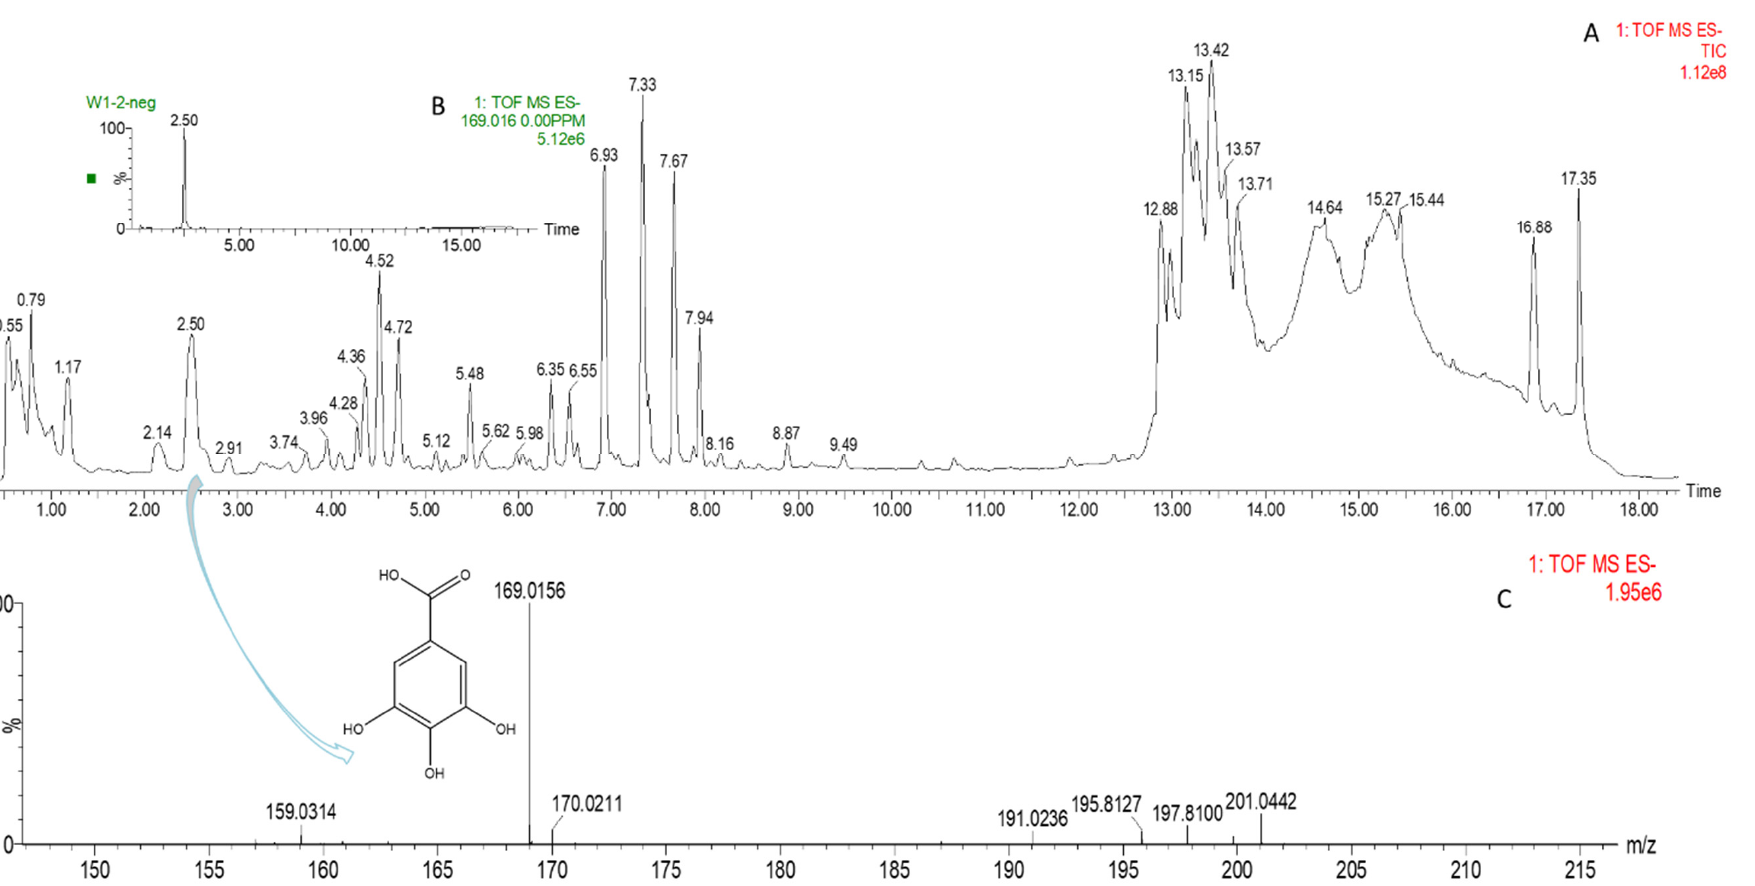
Figure 4. ( A )Representative mass spectrogram of phenolic compounds from peach tissue extract from m/z 100 to 1000 (negative ionization mode); ( B ) mass spectrogram (MS) of galic acid at m/z 169.016; ( C ) MS/MS at 2.50 RM (negative ionization mode).